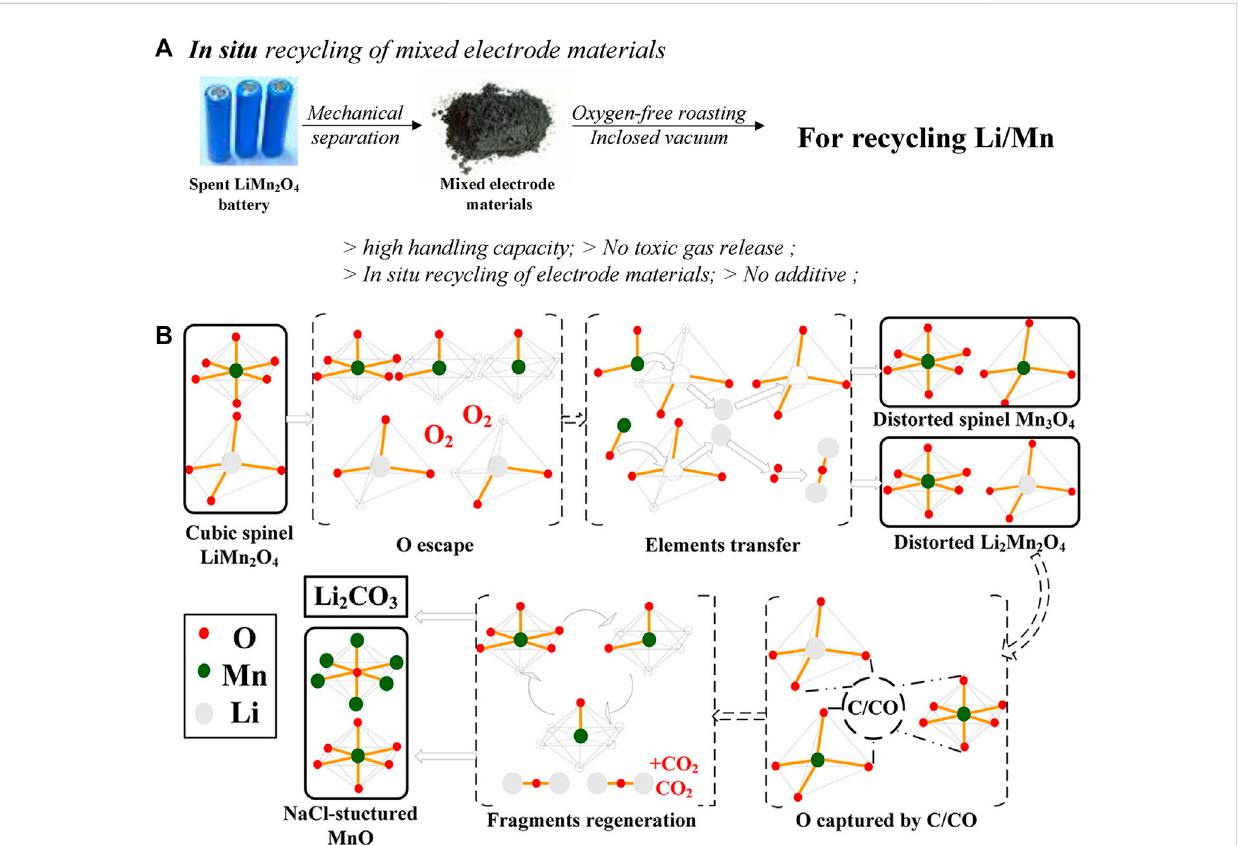
FIGURE 5 (A) Schematic diagram of vacuum carbothermal reduction; (B) schematic diagram of LMO collapse mechanism and Li 2 CO 3 formation during vacuumcarbothermalreduction;Carbon,thermalreductiontechnology,canbecarriedoutnotonlyinavacuumandlow-pressureenvironmentbutalso in an inert atmosphere. Lombardo et al.(Lombardo et al. (2019)) reported a method of recovering lithium carbonate in LCO, LMO and LNO by using carbonasreducingagentinanitrogenatmosphere.TheNi,CoandMninitissuccessfullyconvertedintometaloroxide.Lithiumexistsintheformof Li 2 CO 3 and Li 2 O and is roasted at 700 ° C for 1.5 h. With the decomposition of the positive active material, the binder in it also completes the decomposition at high temperatures. However, during the pyrolysis process, the graphite was not completely reacted. Only a small part of the graphite participated in the reduction reaction, and the remaining graphite remained in the